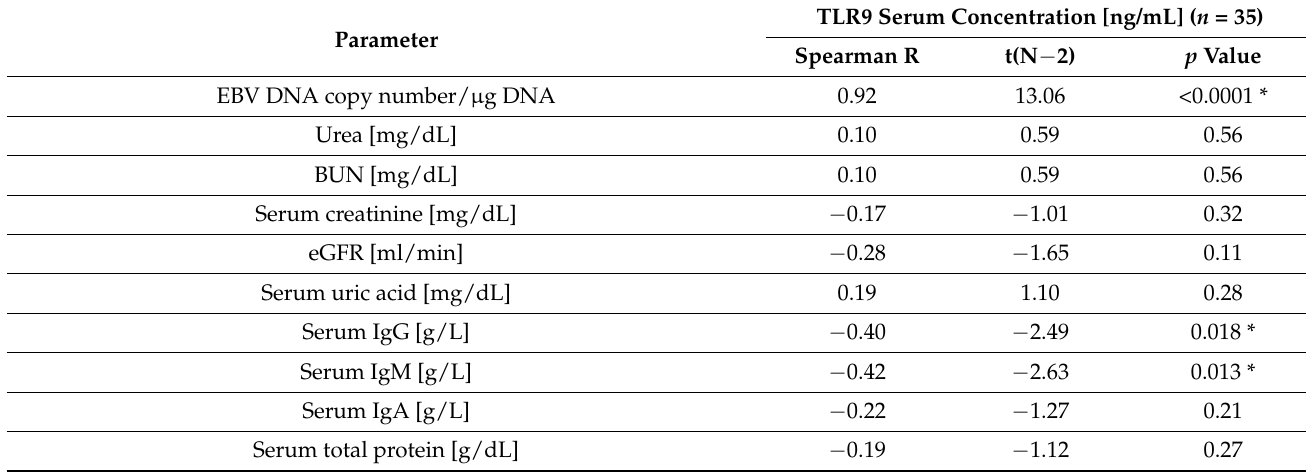
Table 6. Correlation between serum TLR9 concentration and selected morphological, biochemical and immunological parameters for patients diagnosed with